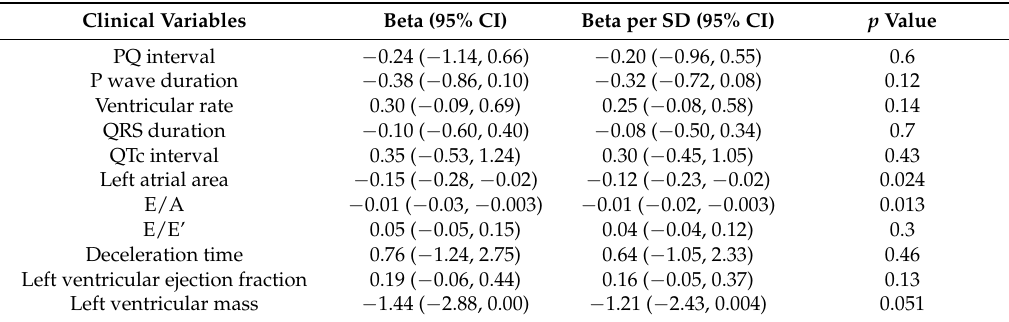
Table 3. Multivariable-adjustedlinearregressionanalysesofhomoarginineinrelationtoelectrocardiographic and echocardiographic variables in the total